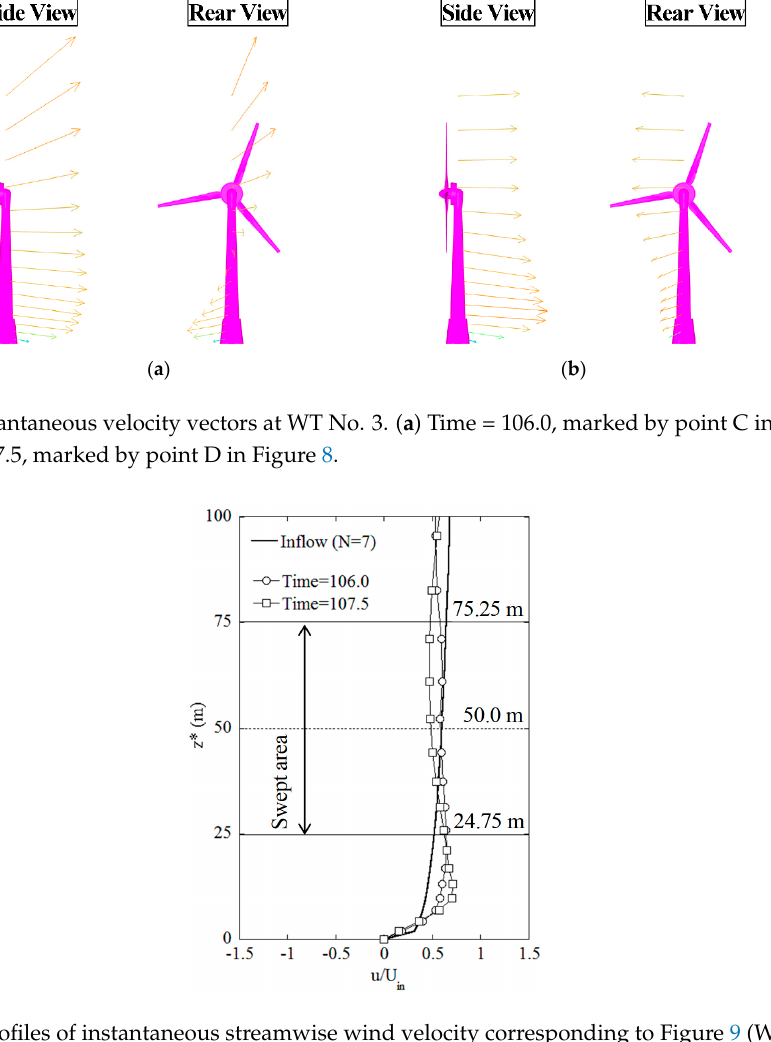
Figure 8. Temporal changes of the angle of the wind on the horizontal (x–y) and the vertical (x–z) cross-sections at the hub height (50.0 m above the terrain surface) in the case of WT No.3. Duration of non-dimensional time on the horizontal axis is approximately 45.0 min (for U in = 5.0 m/s).